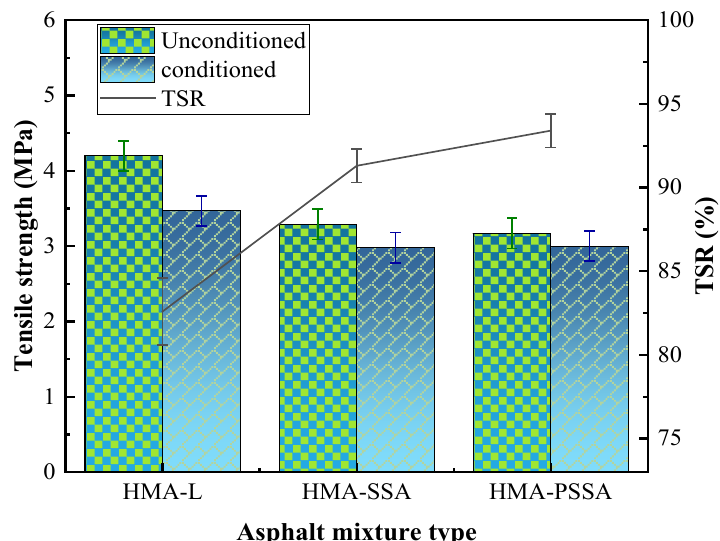
Figure 18. Freeze-thaw splitting test results.